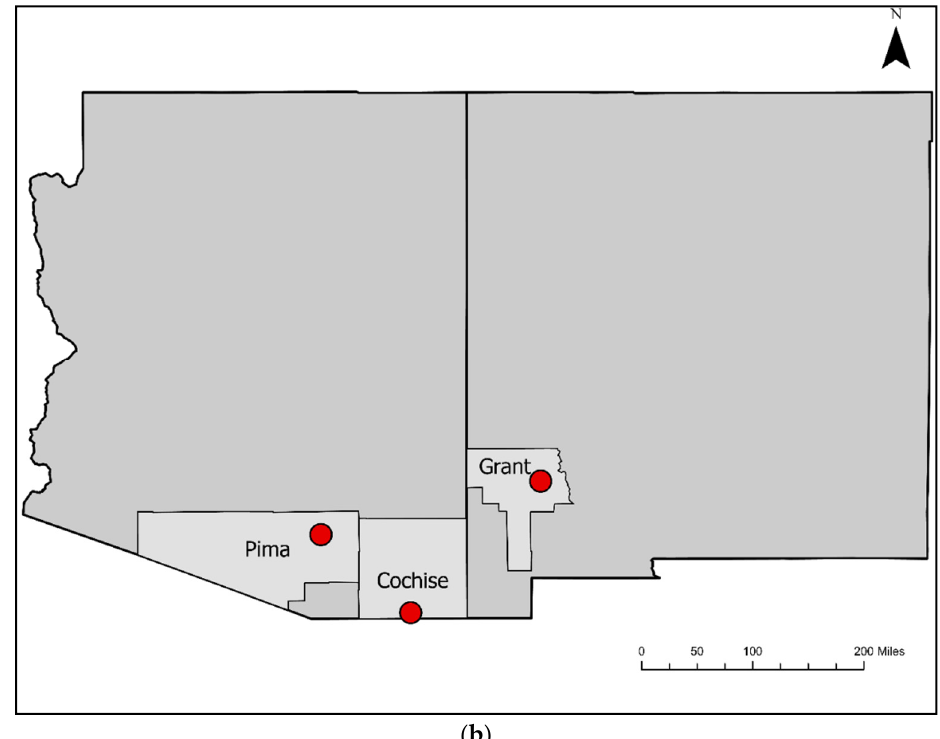
Figure 1. Triatomine collection sites in southern Arizona (Pima and Cochise Counties), and southern New Mexico (Grant County). Both states are located in the southwestern contiguous United States, shown in dark grey ( a ). Mites were found on triatomines from both Pima County, AZ, and Grant County, NM, indicated by red circles ( b ).